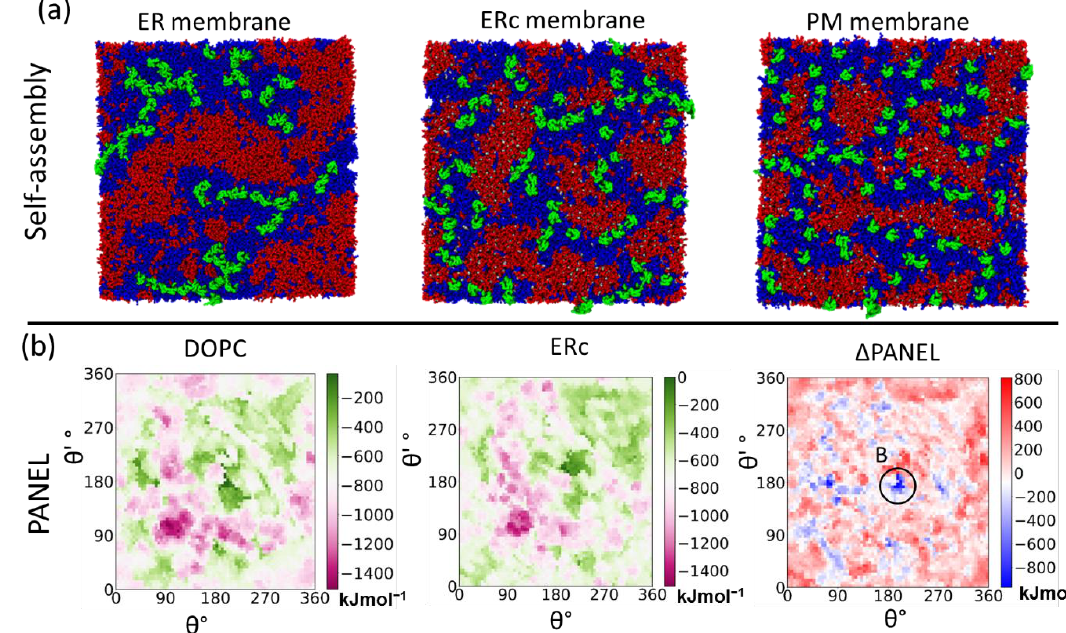
Figure 8. Effects of lipid complexity on claudin-5 dimerization. ( a ) Snapshots (top view) of self-assembled claudins (green) embedded in ER, cholesterol-enriched endoplasmic reticulum (ERc), and plasma membrane (PM) membranes with saturated lipids (red), unsaturated (blue), and cholesterol (white). ( b ) PANEL plots generated for claudin-5 dimers embedded in symmetric DOPC bilayer and ERc membrane. The ΔPANEL plot shows stabilization (blue) and destabilization (red) of the dimer geometries due to change in lipid environment DOPC to ERc. The stabilized dimer B location is marked (circle, black) on the ΔPANEL plot.